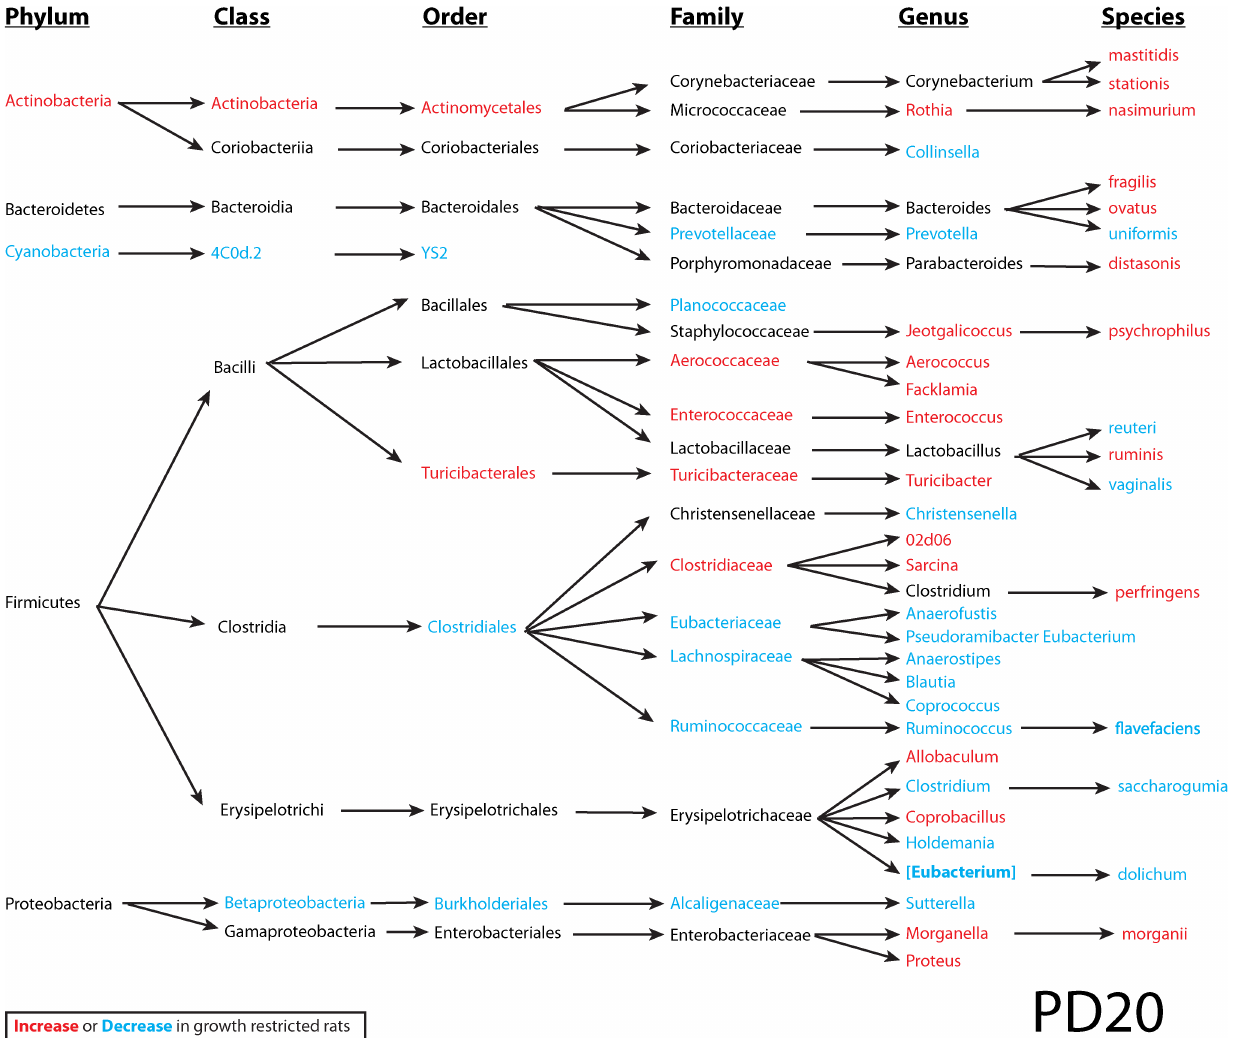
Fig 7. Colon microbial taxa at PD20. Significantly altered colon microbialtaxa by diet at PD20. In red are taxa that increase,and blue are taxa that decreasein growth-restricted rats. The significancewas determined using two-way ANOVA (iron treatment X diet) basedon relative abundancedata. The significancecut-off is p < 0.05. Disclaimer: in this small-scale pilot study (n = 4–6), multiplecomparisons were not adjusted,and therefore results may containfalse discoveries. Future confirmation is needed.